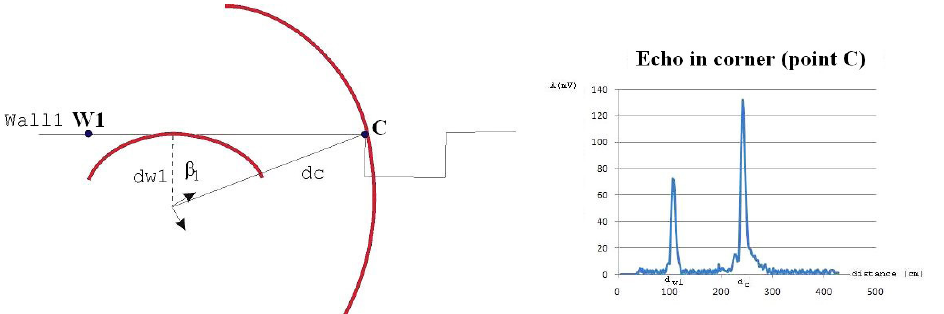
Figure 7. Corner produced by a protruded